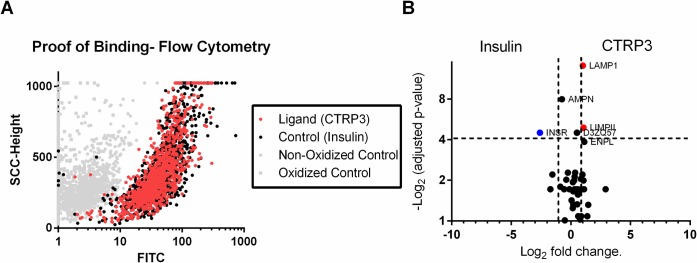
H4IIE rat hepatoma cells were treated with TriCEPs conjugated to Insulin or CTRP3.A, The binding of ligands to cell surface receptors was detected by Steptavidin FITC (The TriCEPS™ reagent contains biotin) and analyzed for mean fluorescent intensity (MFI). Representative image (20% of points shown) of raw flow data from vehicle treated. B, The samples were analyzed by Mass spectrometry (Dualsystems Biotech, AG) and the adjusted p-value (ANOVA, adjusted for multiple comparisons) for the differential abundance of each protein was plotted against the magnitude of the fold enrichment between insulin and CTRP3 samples. Proteins are considered significant if fold change >2 and p<0.05. Two proteins (LAMP1 and LIMPII) were statistically significant. Raw data for Fig 4, S2 File.